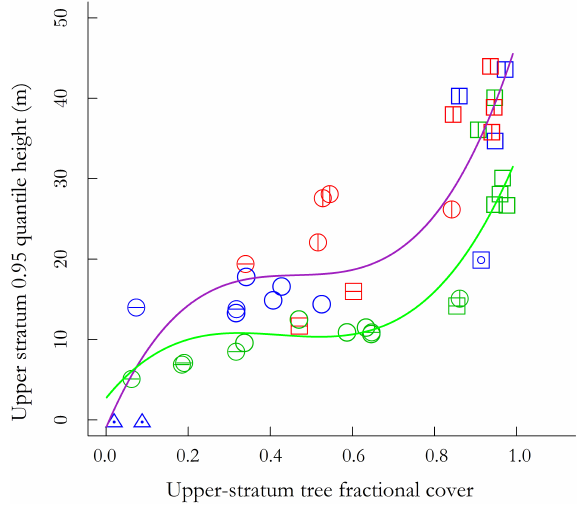
Figure 7. Relationship between the upper stratum 0.95 quantile height and total woody plant crown cover ( H > 1 . 5m). Symbols as in Fig. 1. The lines show results of rank based linear model re- gression fits for which South America (green line) is significantly different to Africa and Australia ( p < 0 . 05) which in turn do not differ from each other ( p > 0 . 1: purple